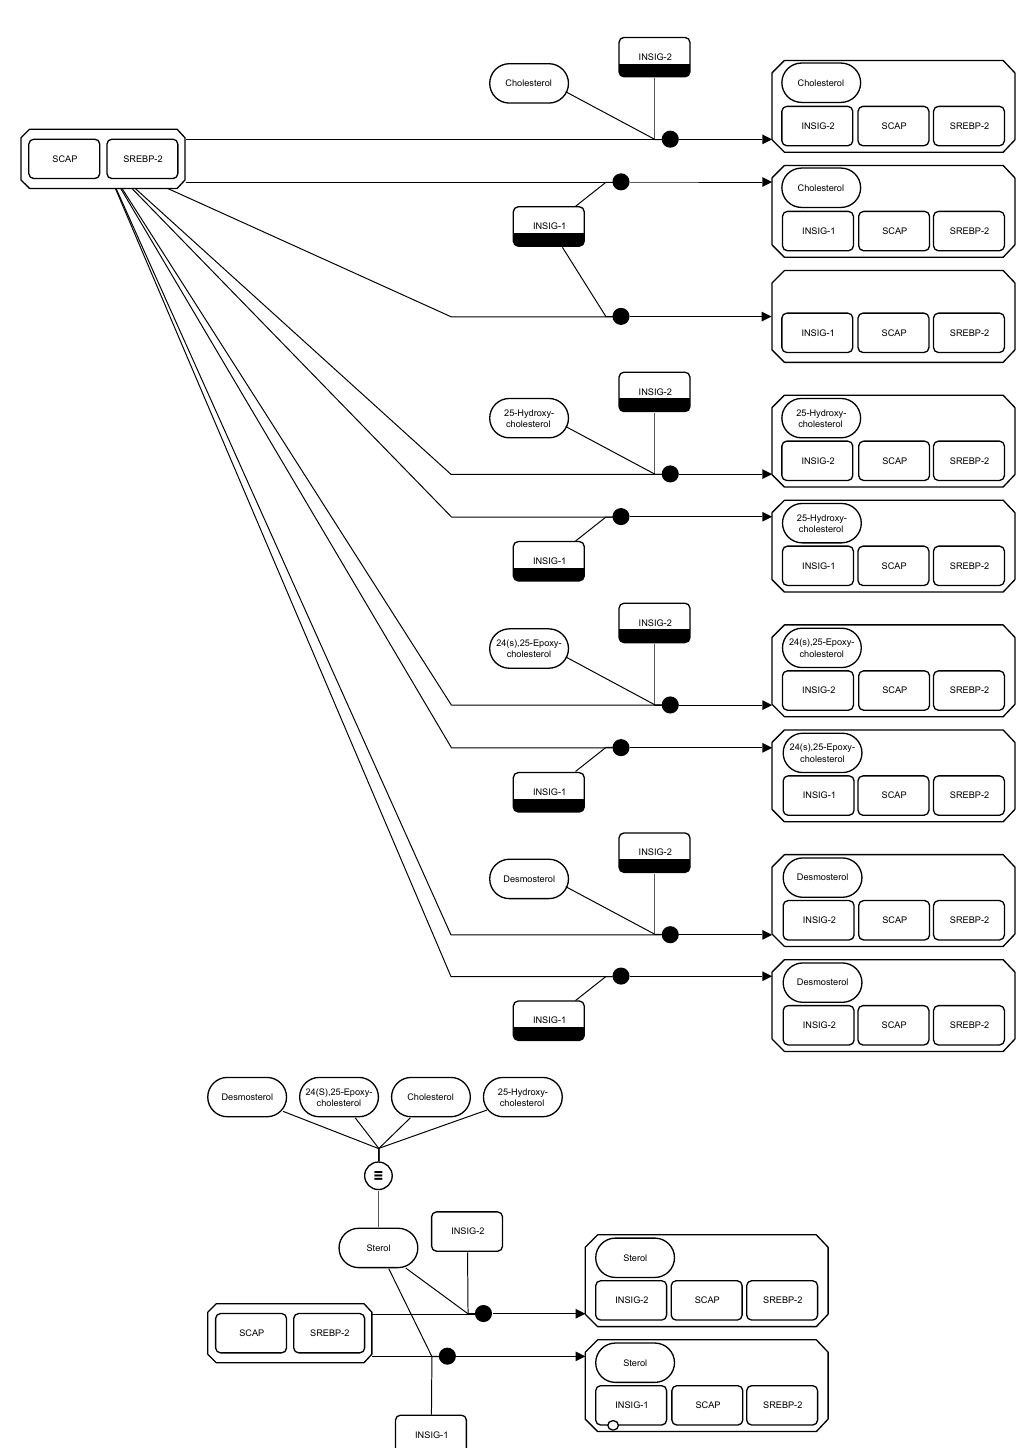
Figure B.2: First step of the inhibition of cholesterol synthesis in presence of sterols. A. Without an equivalence operator . B. With an equivalence operator